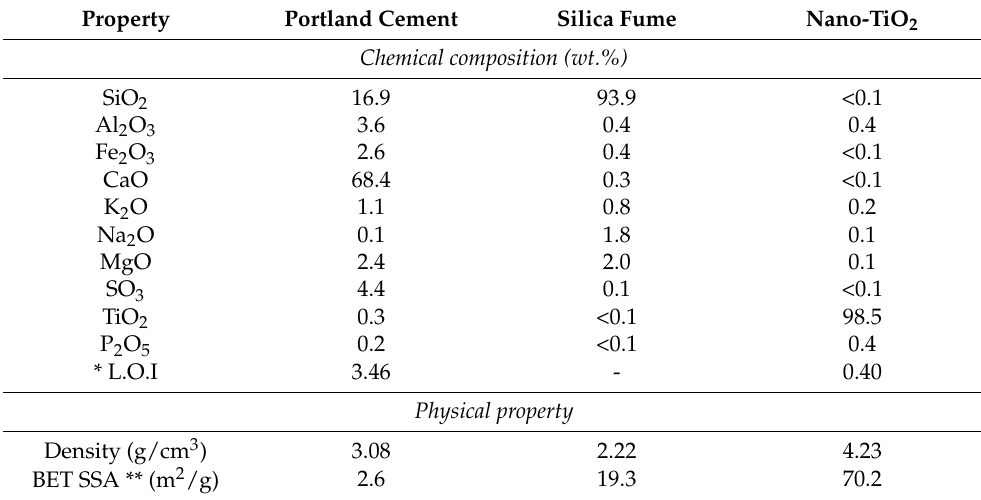
Table 1. Chemical composition and physical properties of the binder materials used. Property